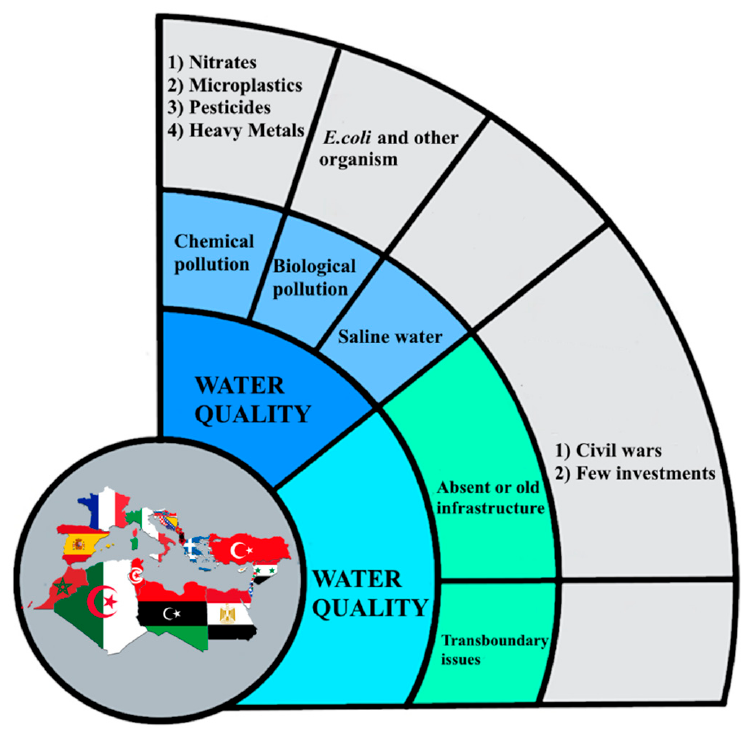
Figure 4. Major water ‐ related problems in Mediterranean Countries.